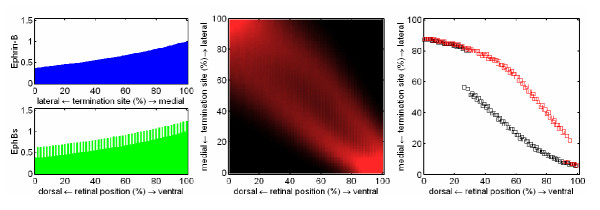
Mapping in heterozygous Isl2/EphB knock-ins. Two bifurcations are observed, one in medial, another in lateral SC.